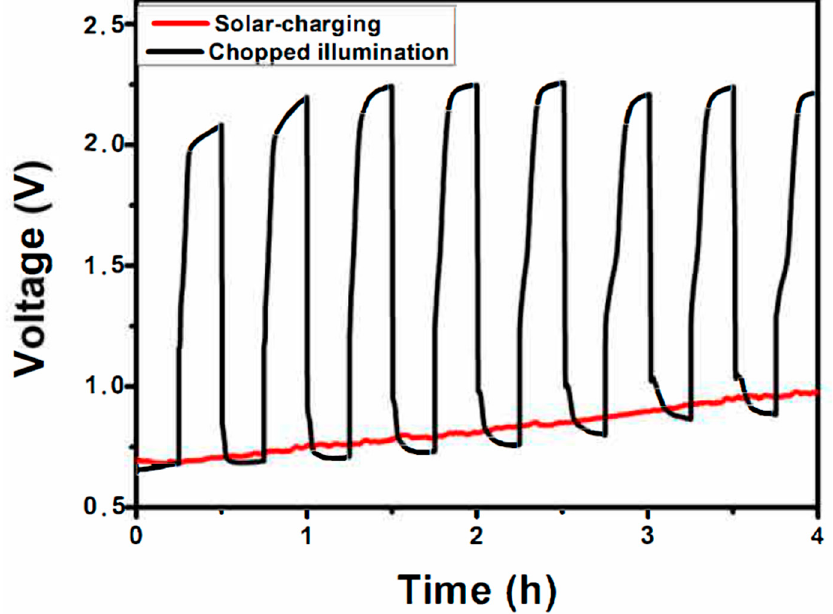
Figure 6. Stability test during several hours of operation at continuous (red line) and chopped illumination (black line) for the system composed of Nb 2 O 5 -CdS as photoelectrode and Zn as the counter-electrode in an alkaline electrolyte. For the chopped illumination, the lines on the bottom represent the photo-assisted charging, matching the potentials shown by the red curve. The current density was 0.2 mA cm − 2 .